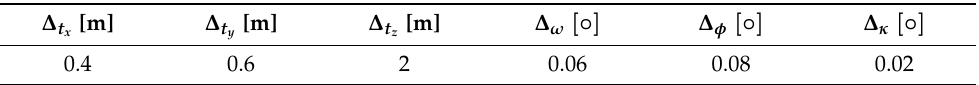
Table 2. The maximum difference between the estimated pose parameters over 1902 epochs by means of IEKF and DSIEKF.